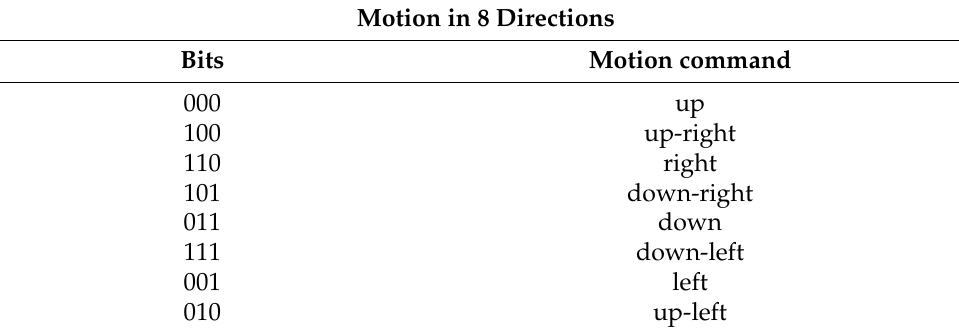
Table 5. Bit pairs and motion commands on the horizontal plane.